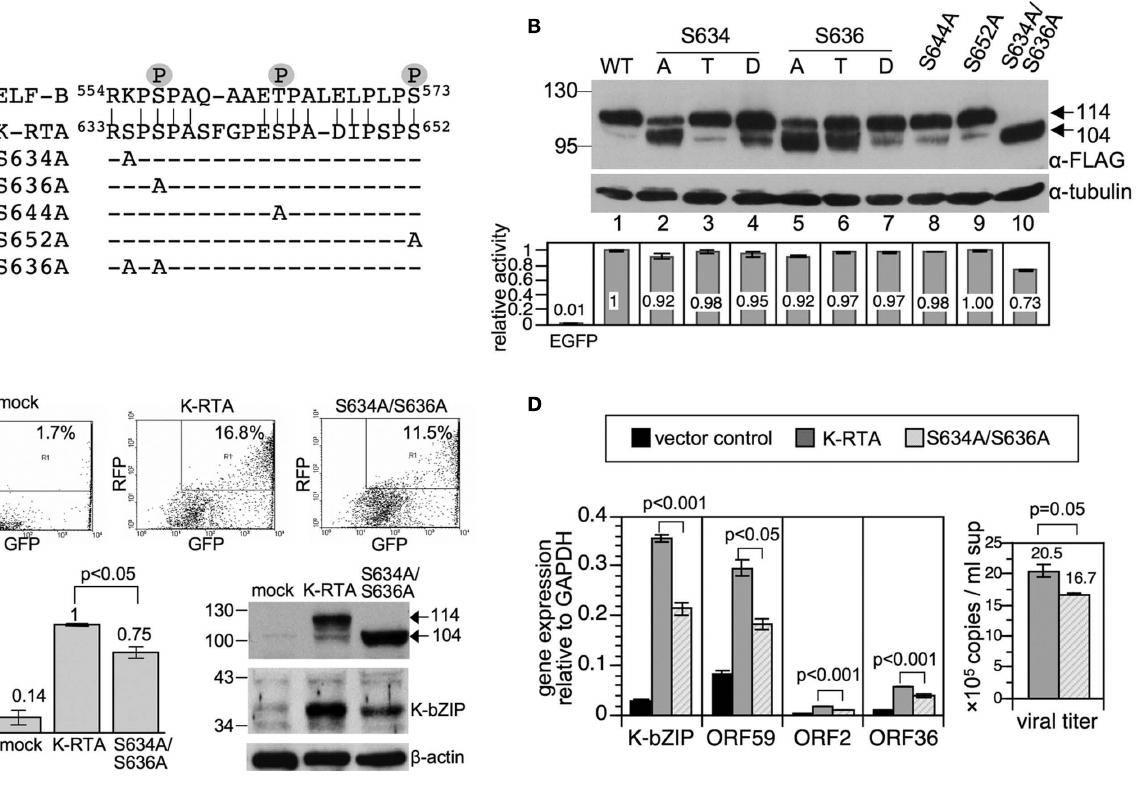
fluorescence-activated cell sorter followed by scoring the percentage of double positive (GFP and RFP) cells in each population, as indicated in the upper right of each panel. Untreated cells (mock) served as a control. (Lower left) results derived from four independent experiments are summarized in the schematic chart. Data are presented as the means ± SD with K-RTA group set to 1. Statistical evaluation was performed with Student’s t -test. (Lower right) induction of expression of lytic protein K-bZIP by K-RTA and S634A/S636A in 293/rKSHV.219 cells was compared in parallel byWestern blot analysis. β -actin served as a loading control. (D) (Left) total RNAs of 293/rKSHV.219 cells transfected with pLenti-FLAG-CPO (vector control), pLenti-FLAG-K-RTA, and pLenti-FLAG-S634A/S636A for 48h were analyzed by quantitative RT-PCR for gene expressions of K-bZIP, ORF59, ORF2, and ORF36. Results from each reaction were normalized to cellular GAPDH. Statistical evaluations were performed by using Student’s t -test. (Right) KSHV viral particles released from K-RTA or S634A/S636A-expressing cells at 72h were determined by comparative quantitative PCR of KSHV DNA polymerase genes (ORF9). Data are presented as means ± SD for three PCR assays in an experiment. Similar results were obtained from two independent experiments; one set of data is